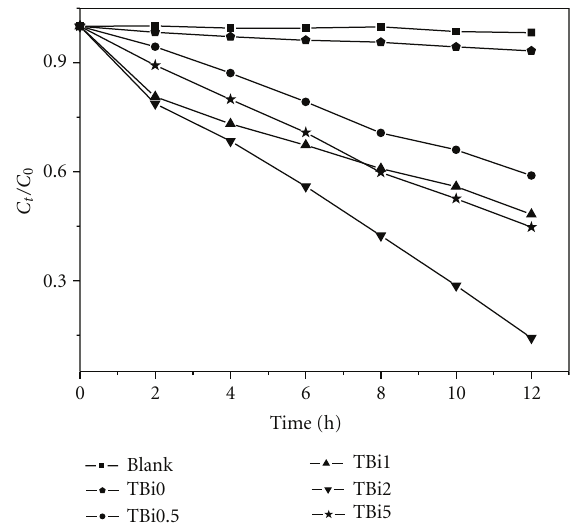
Figure 5: Photocatalytic activity of the Bi-doped TiO 2 spheres